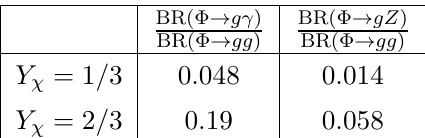
Table 1 . Values of ratios of BRs in di-bosons for the pseudo-scalar octet isosinglet at a mass of 1 TeV. The mass (cid:12)xes the dependence due to the running of the strong gauge coupling, (cid:11) s (1 TeV) = 0 : 0881 is used for this evaluation. The Y (cid:31) = 1 = 3 (2 = 3) will be referred to as the pessimistic (optimistic) case corresponding to its reach in the photon channels, while the decay into gZ is always